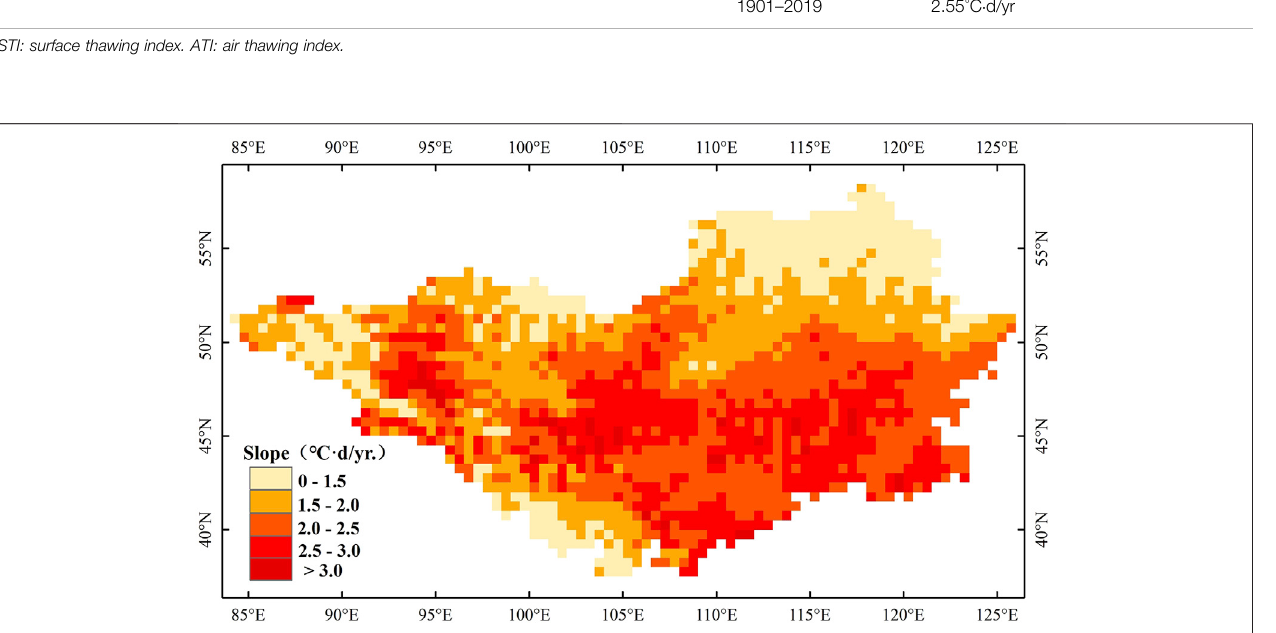
FIGURE 8 | Sen ’ s slope of the thawing index on the Mongolian Plateau from 1901 to